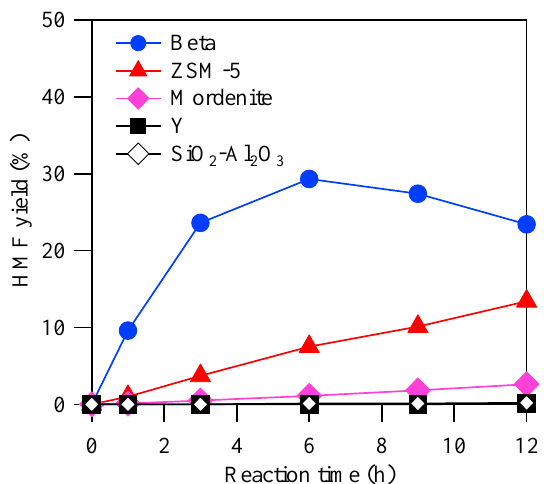
Figure 3. Time-based reaction progression of the hydroxymethylation of furfural towards HMF among four zeolites and normal SiO 2 -Al 2 O 3 in a batch reactor. Reaction conditions: furfural (1 mmol), formalin (5 mL), catalyst (200 mg), temperature (363 K), stirring (500 rpm).